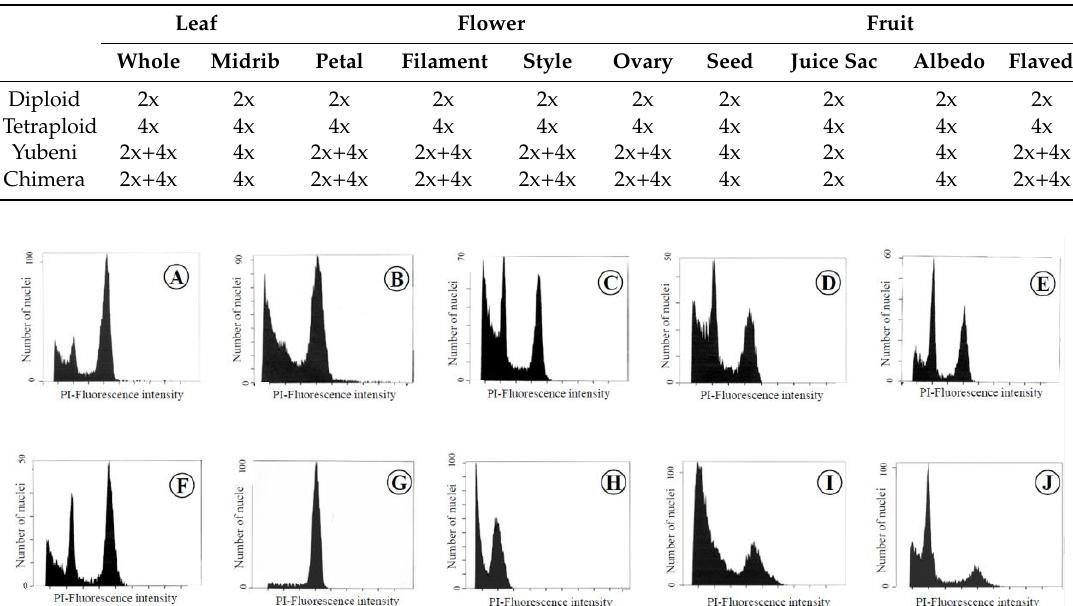
Figure 1. Flow cytometric analysis of each organ and tissue in leaves, flowers, seeds, and fruits of the chimera of the Meiwa kumquat. A : Leaf, B : Midrib, C : Petal, D : Filament, E : Style, F : Ovary, G : Seed, H : Juice sac, I : Albedo, J : Flavedo.